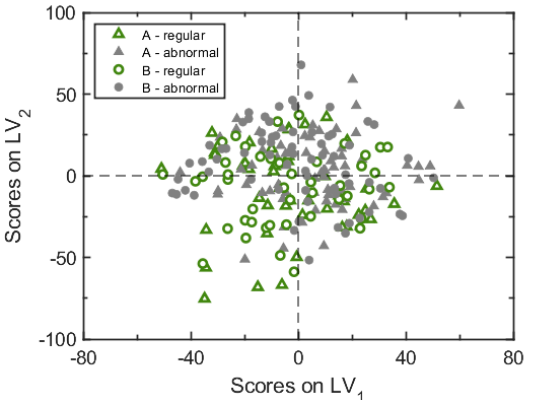
Figure 8. Two-component PLS-DA model for R101. Scores plot (each marker represents a charge to R101 for either Step A or Step B; open markers denote charges eventually requiring no corrections; closed markers denote charges eventually requiring one or two corrections).